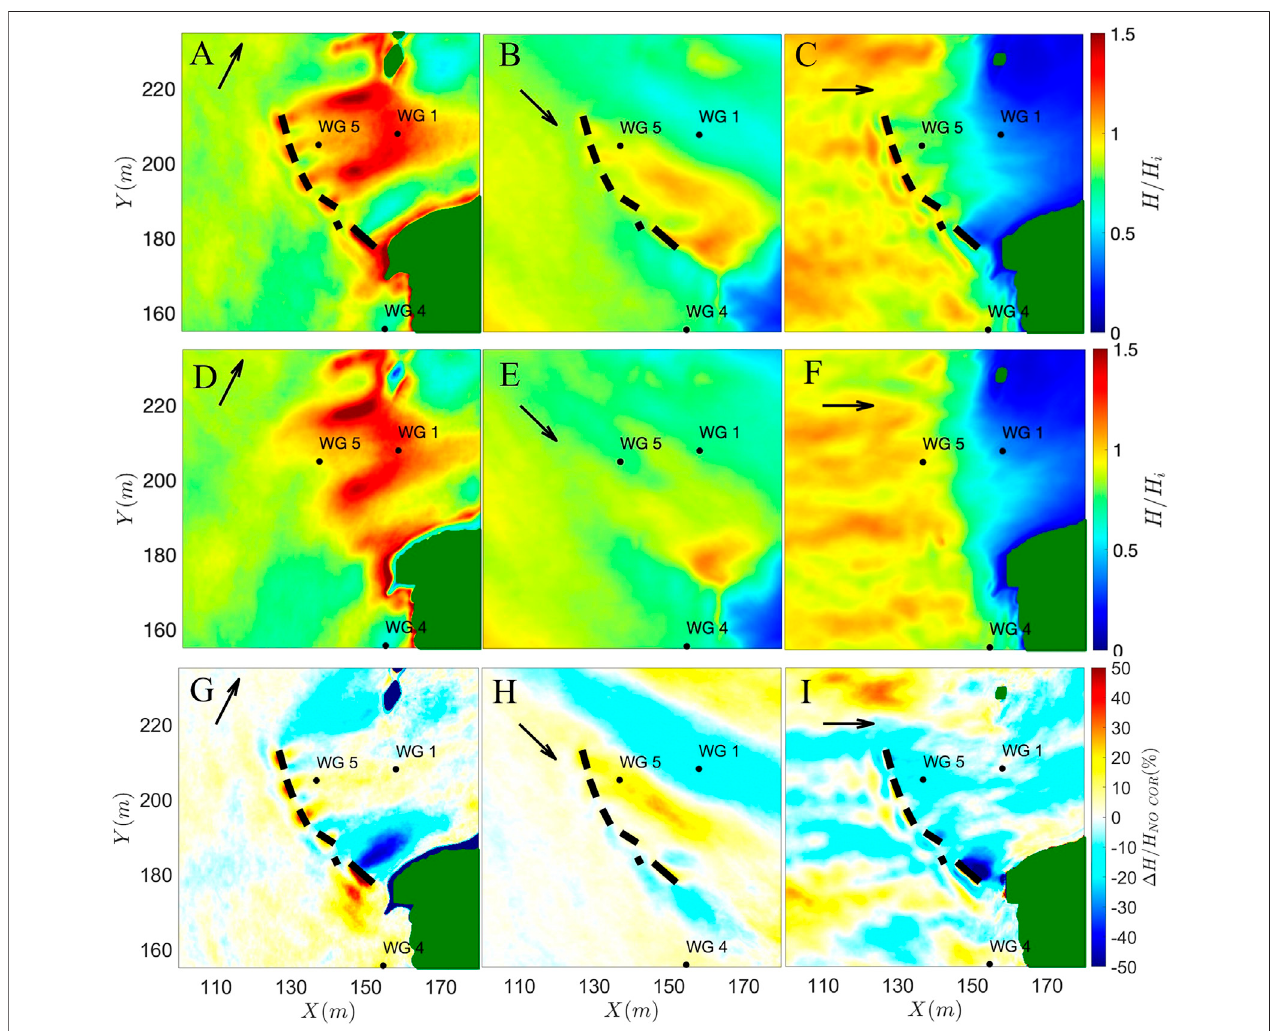
FIGURE 8 | Wave height to offshore wave height ratio for (A,D) Case 1, (B,E) Case 2, and (C,F) Case 3. In panels (A – C) CORs are present in the domain, while in panels (D – F) CORs are removed from the domain. Panels (G – I) illustrate the change of root mean square wave height due to CORs.